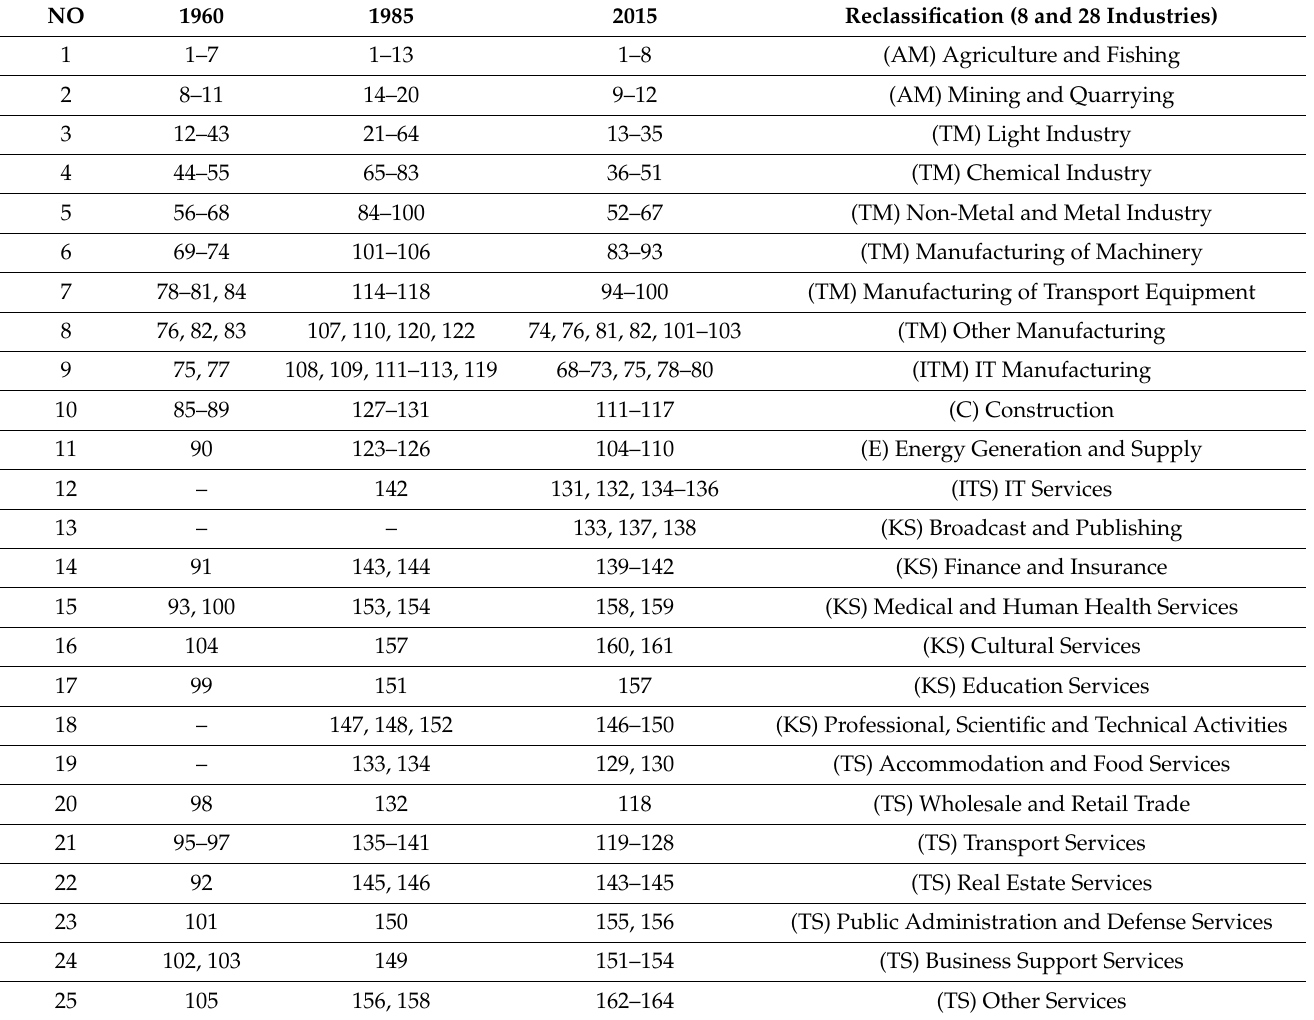
Table A2. Reclassification of smart city industries (unit: industry